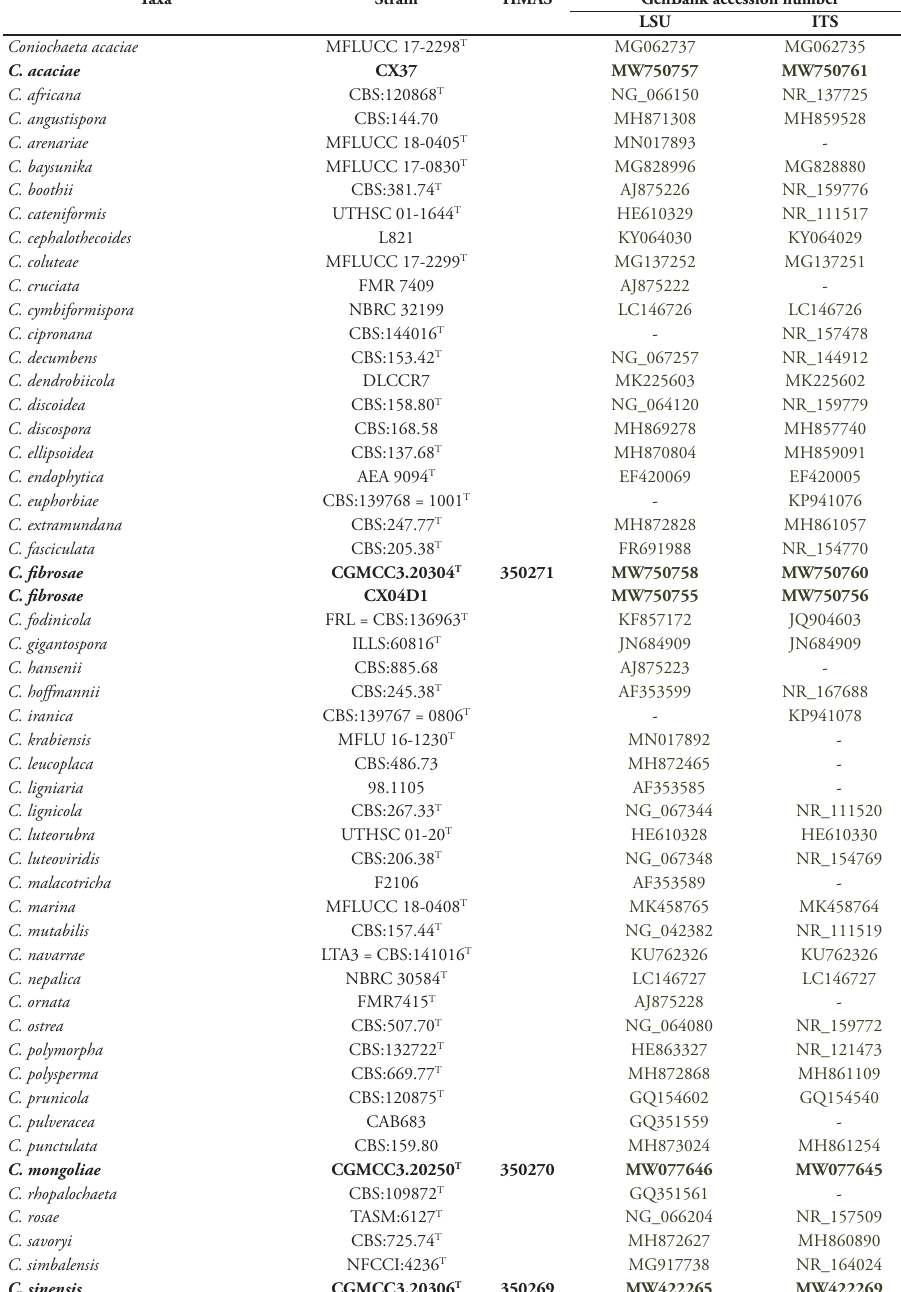
Table 1. GenBank accession numbers Coniochaeta species used for the phylogenetic analyses. T = ex-type